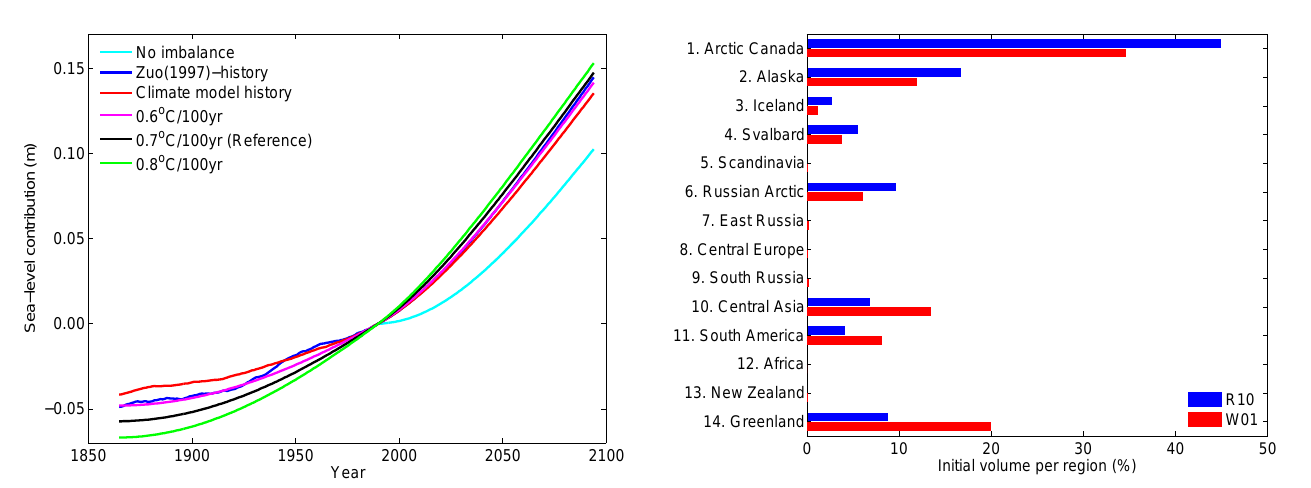
Fig. 5. GIC sea-level contribution (m) for different imbalance op- tions, R10 glacier inventory.